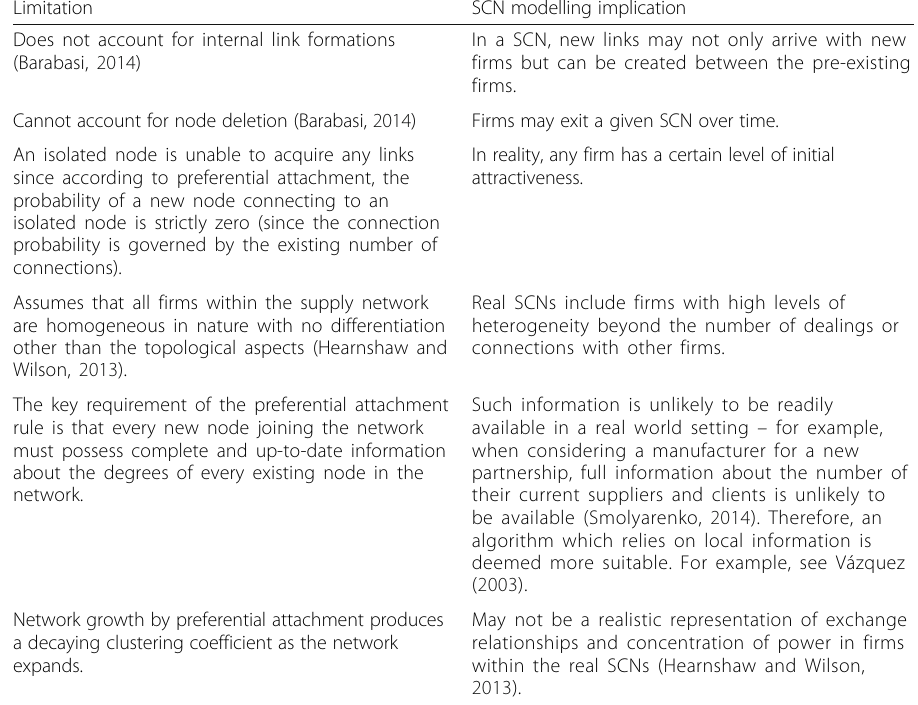
Table 1 Limitations of BA Model in Modelling SCNs Limitation SCN modelling